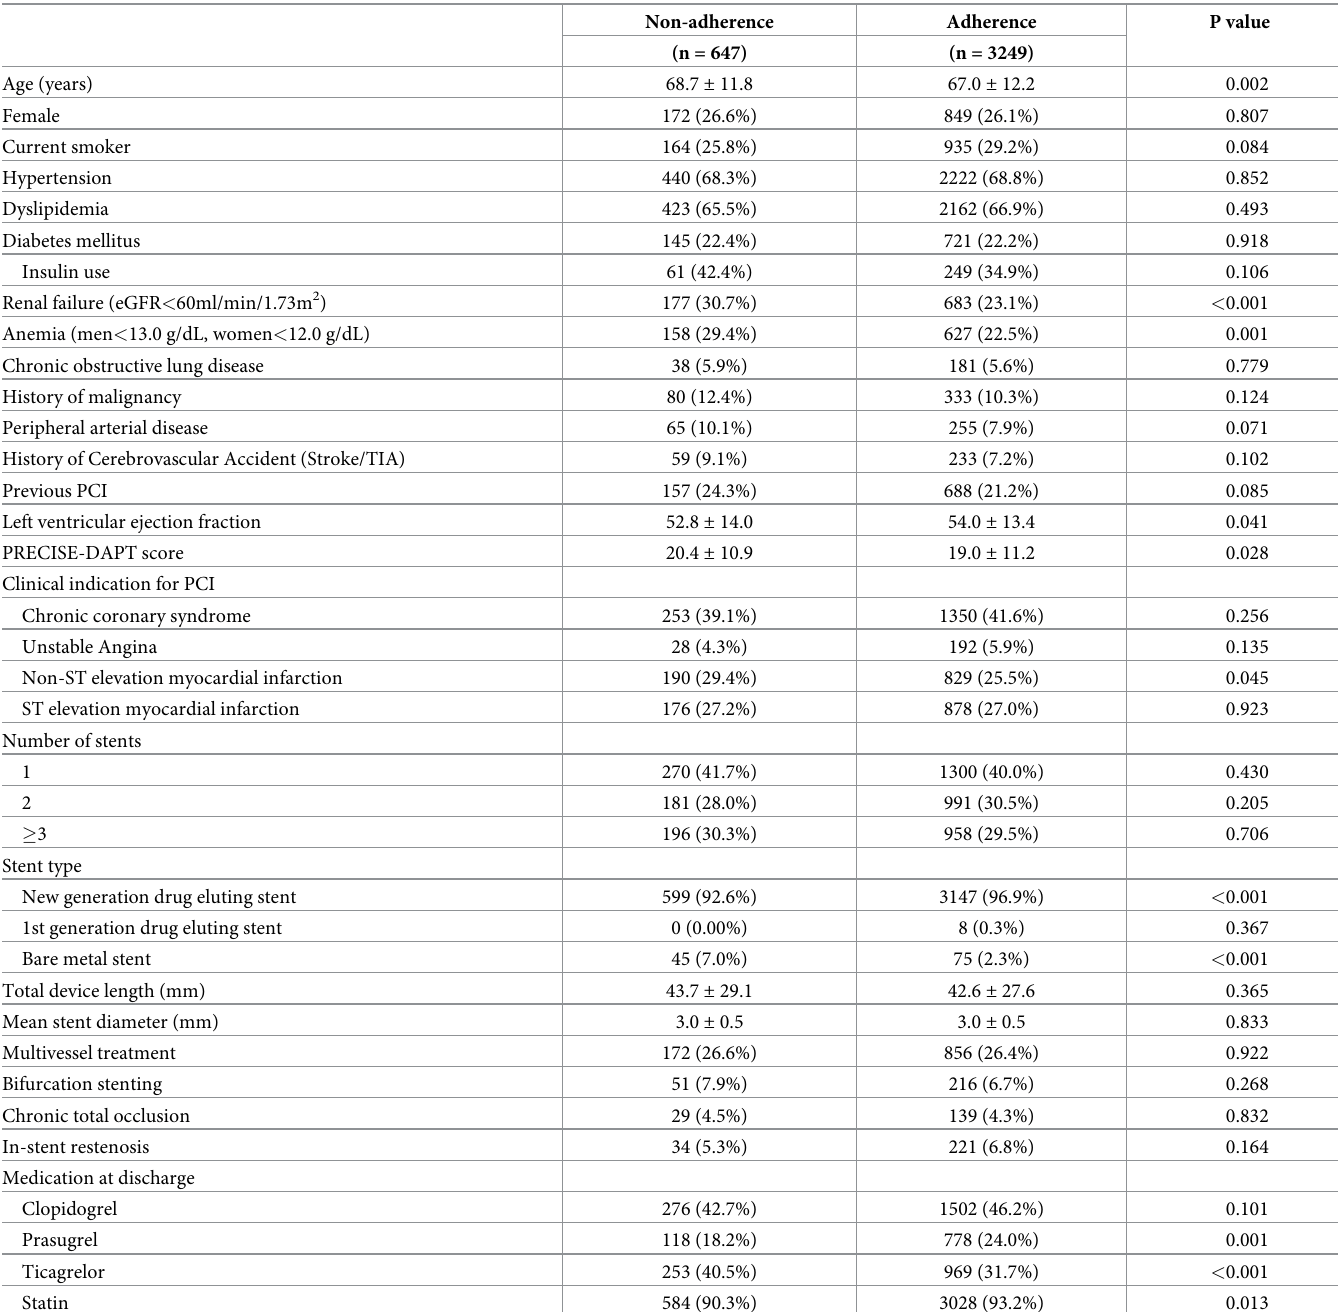
Table 1. Baseline